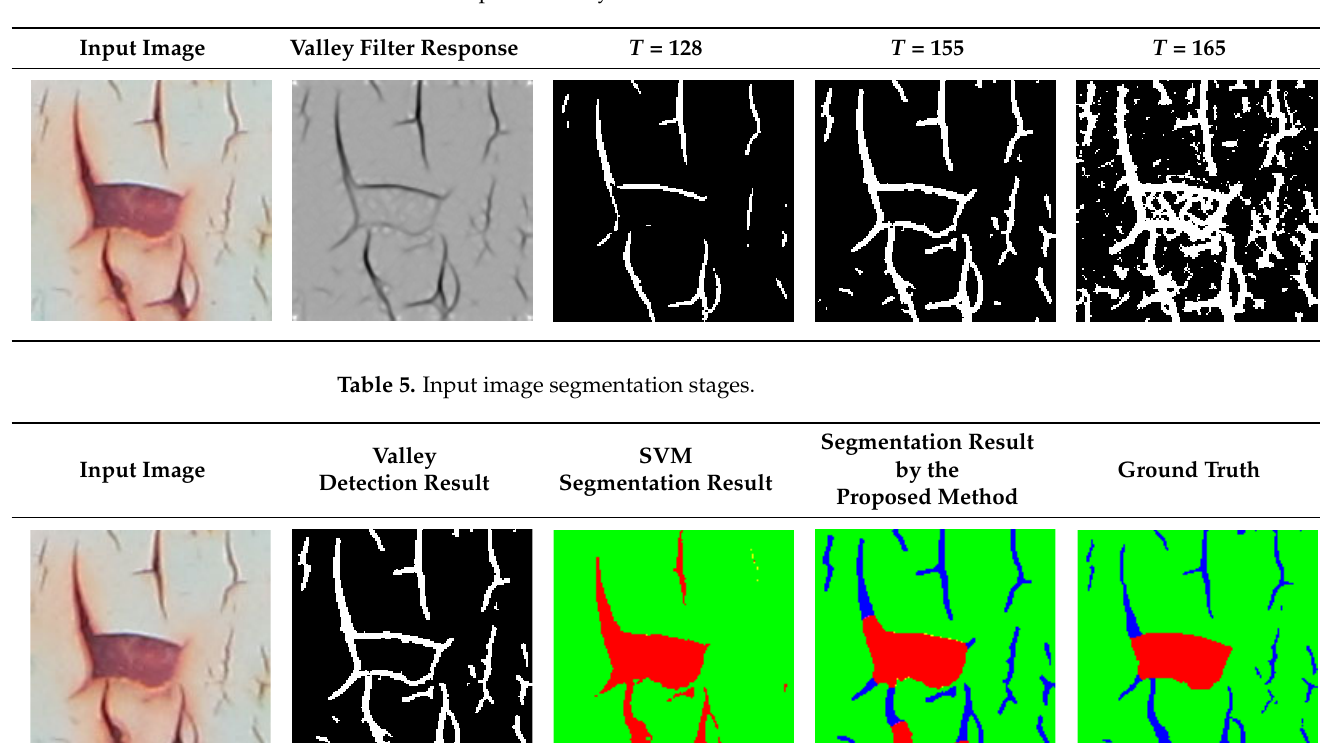
Table 5. Input image segmentation stages.